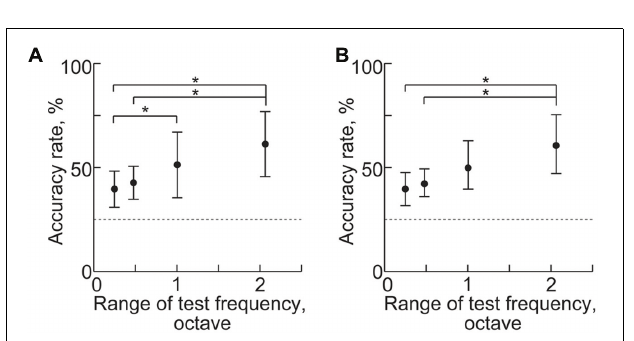
FIGURE 11 | Decoding of test frequencies in several frequency ranges. (A,B) Decoding accuracy in (A) high-gamma power and (B) PLV with respect to the range of the four test frequencies (shown in Table 1 ). Asterisks indicate statistical significance: ∗ p < 0.05 (Wilcoxon signed-rank